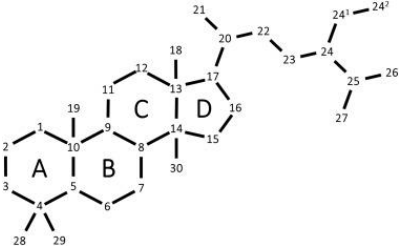
Figure 5. Schematic structure of the steroid skeleton.